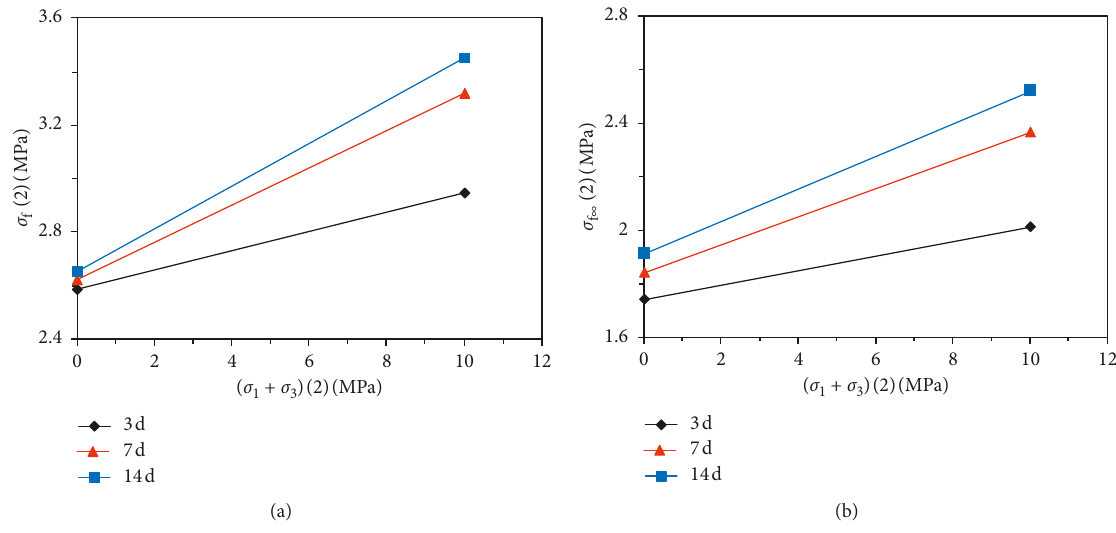
Figure 10: Strength envelopes of frozen clay: (a) instantaneous strength and (b) long-term strength. Table 6: Instantaneous and long-term Mohr–Coulomb strength parameters.